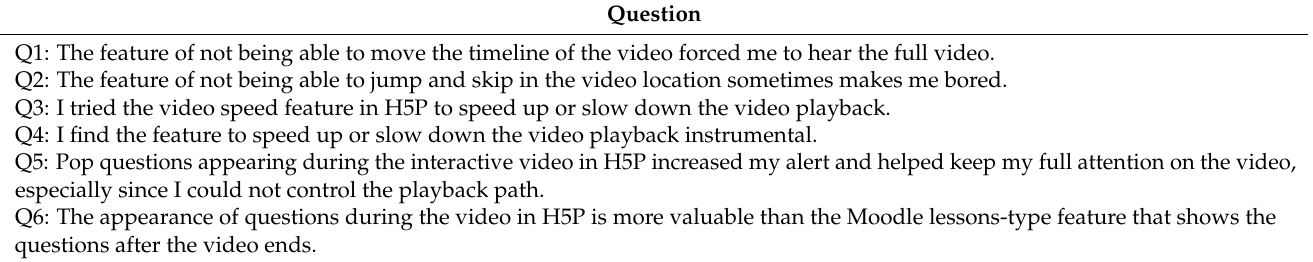
Table A2. Likert-scale questions of H5P